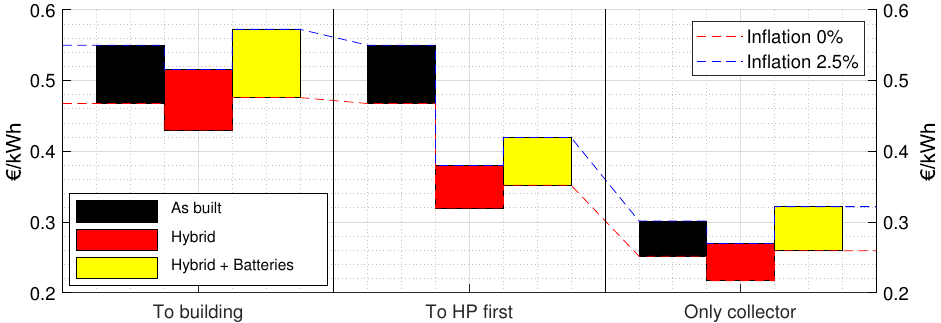
Figure 16. LCOH summary per scenario and